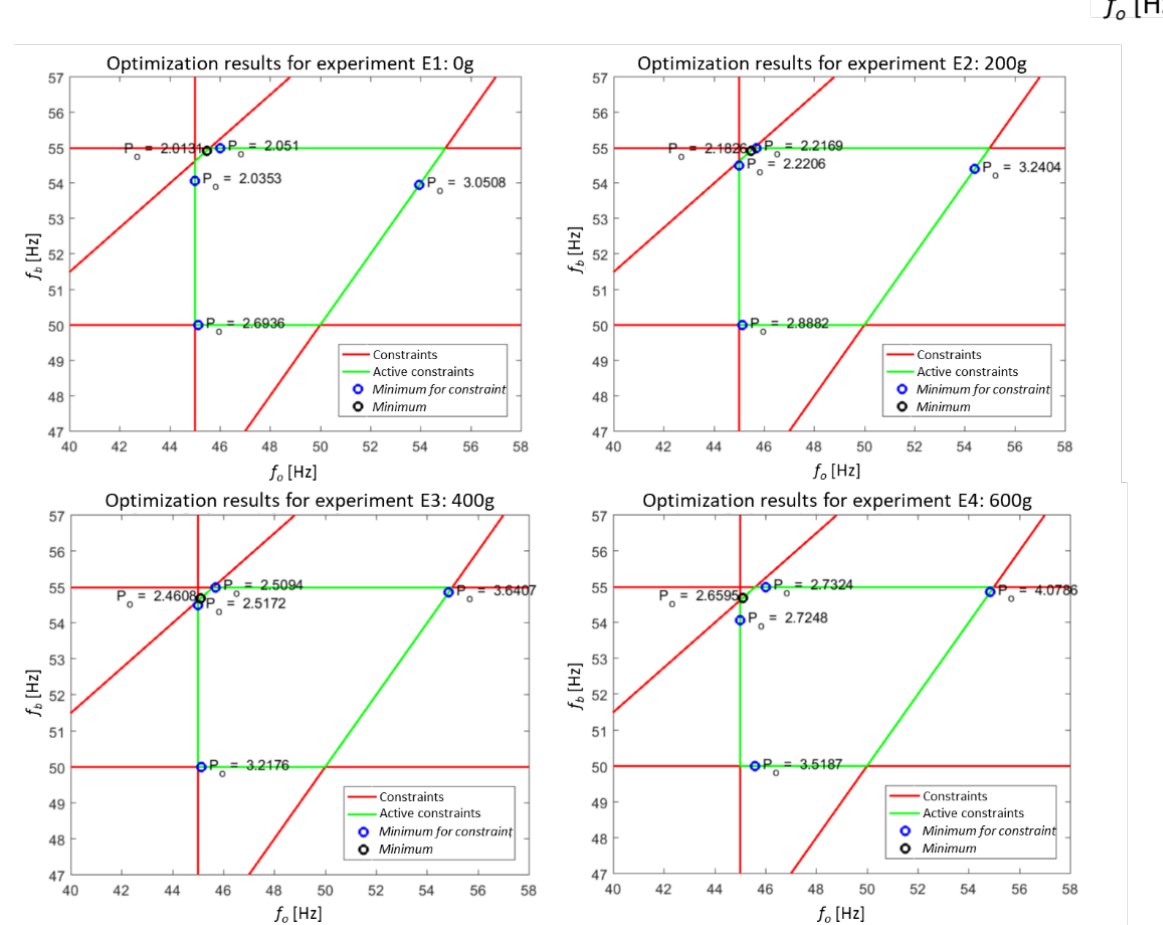
Figure 15. The results obtained from the optimization algorithm for the experiments with different mass of grinding medium.